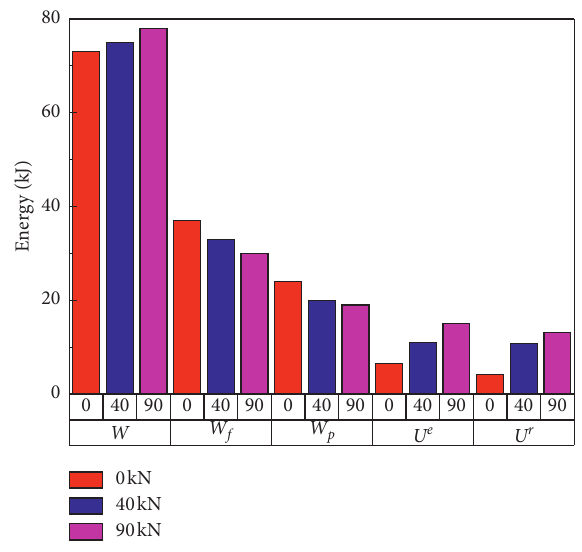
Figure 5: Data of each energy